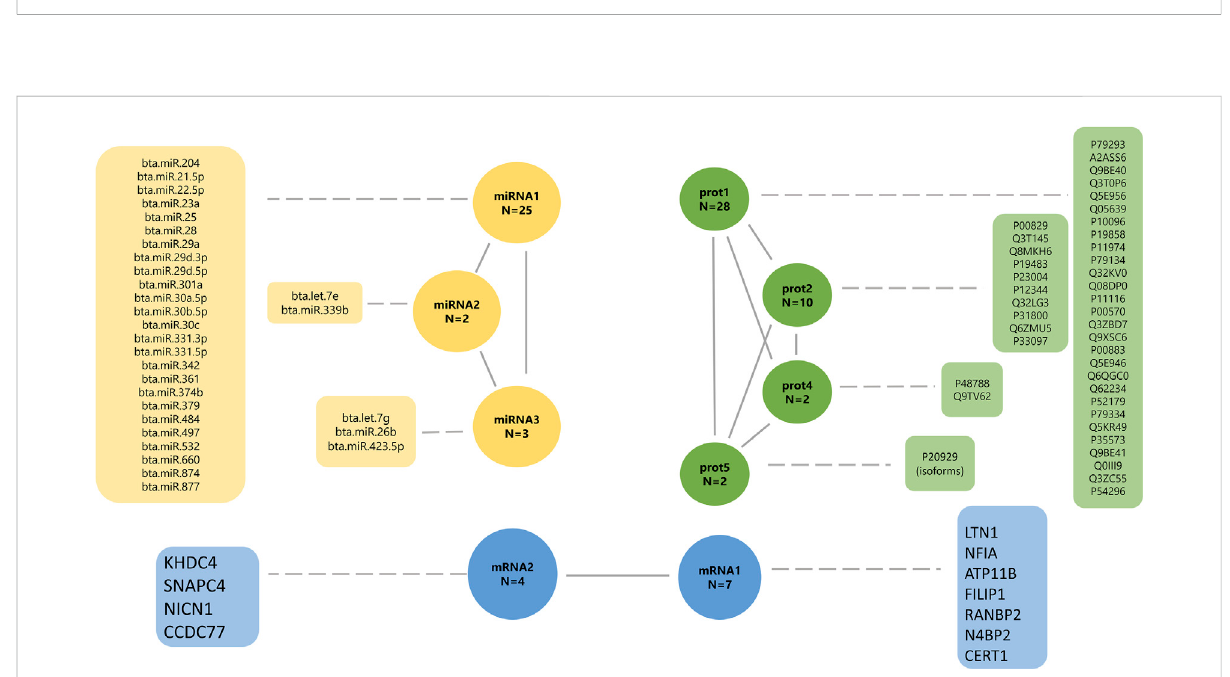
Final underlying latent structures of miRNA (yellow), proteins (green), and mRNA (blue) generated by exploratory factor analysis. N denotes the total number of features in each latent